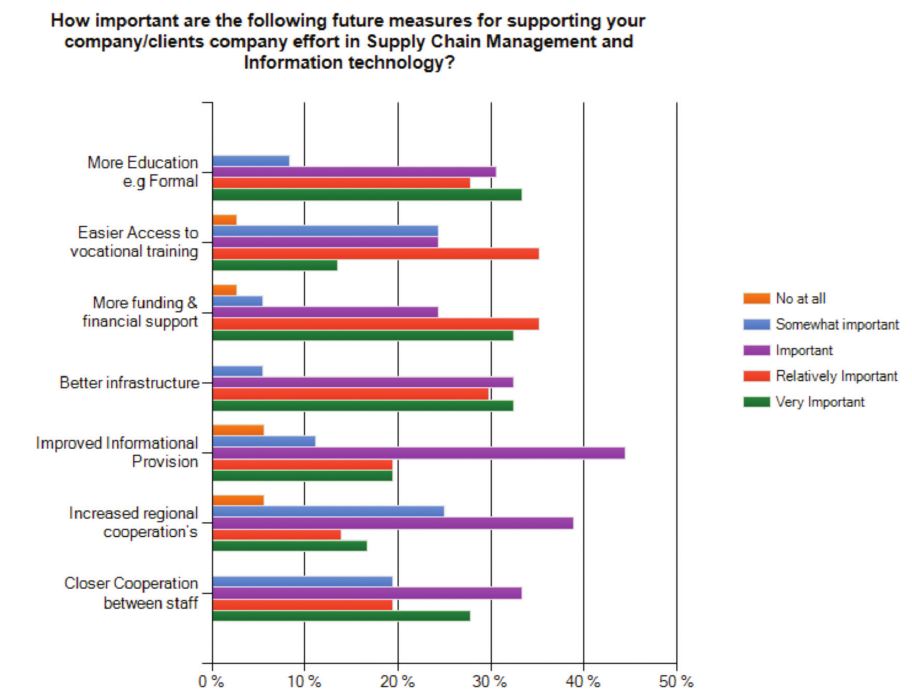
Figure 8: Measures for supporting the adoption of